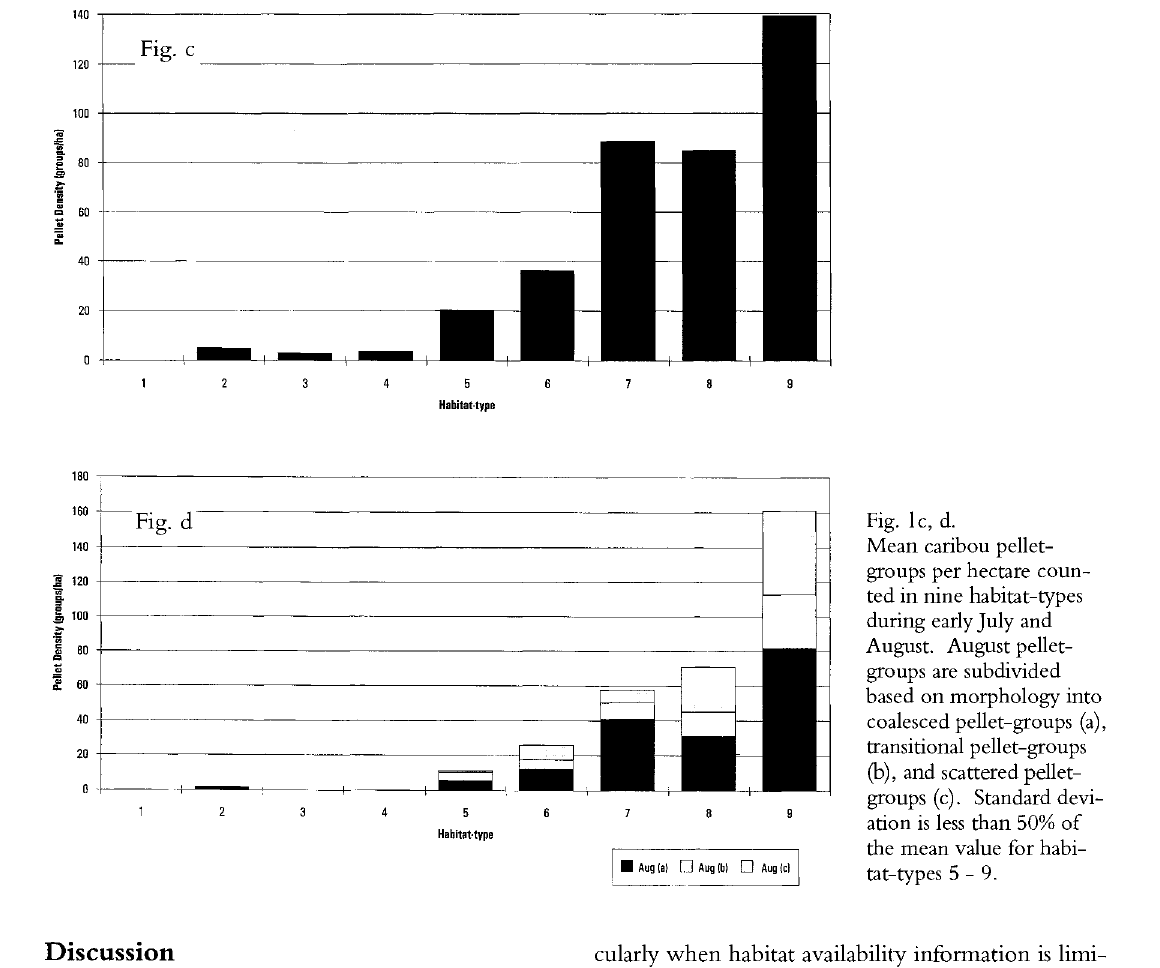
Fig. lc, d. Mean caribou pellet- groups per hectare coun ted in nine habitat-types